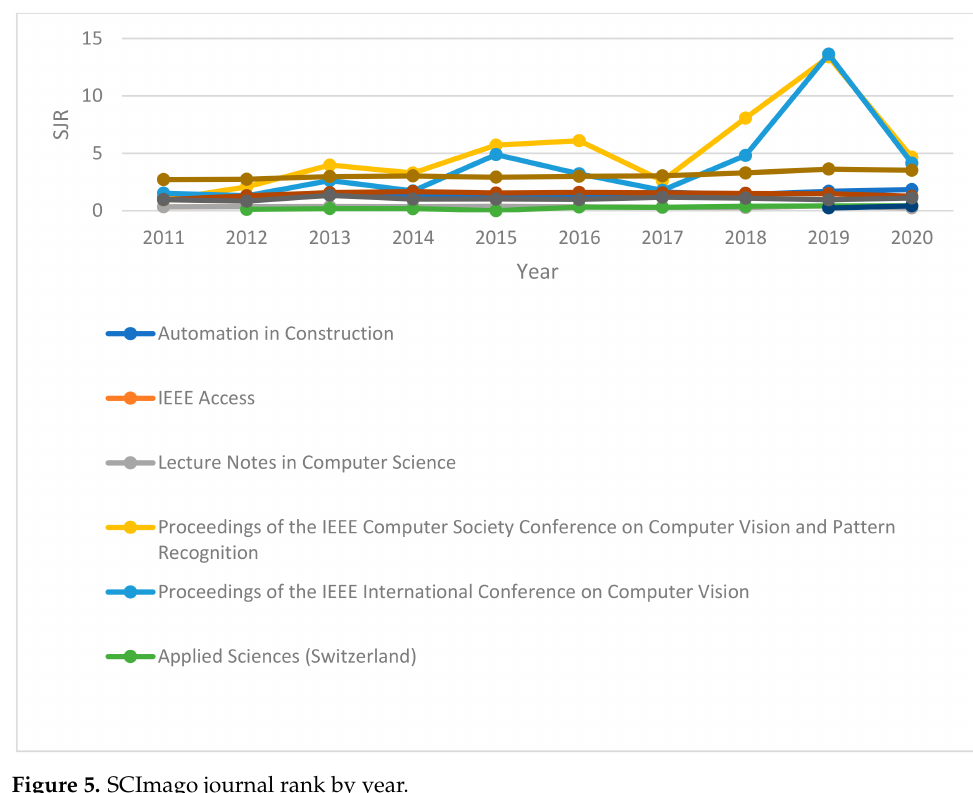
Figure 5. SCImago journal rank by